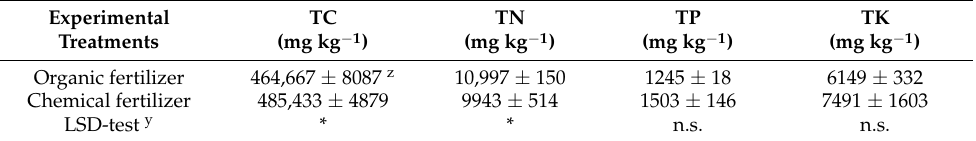
Table 1. The total carbon (TC), total nitrogen (TN), total phosphorus (TP), and total potassium (TK) contents of apple leaves.